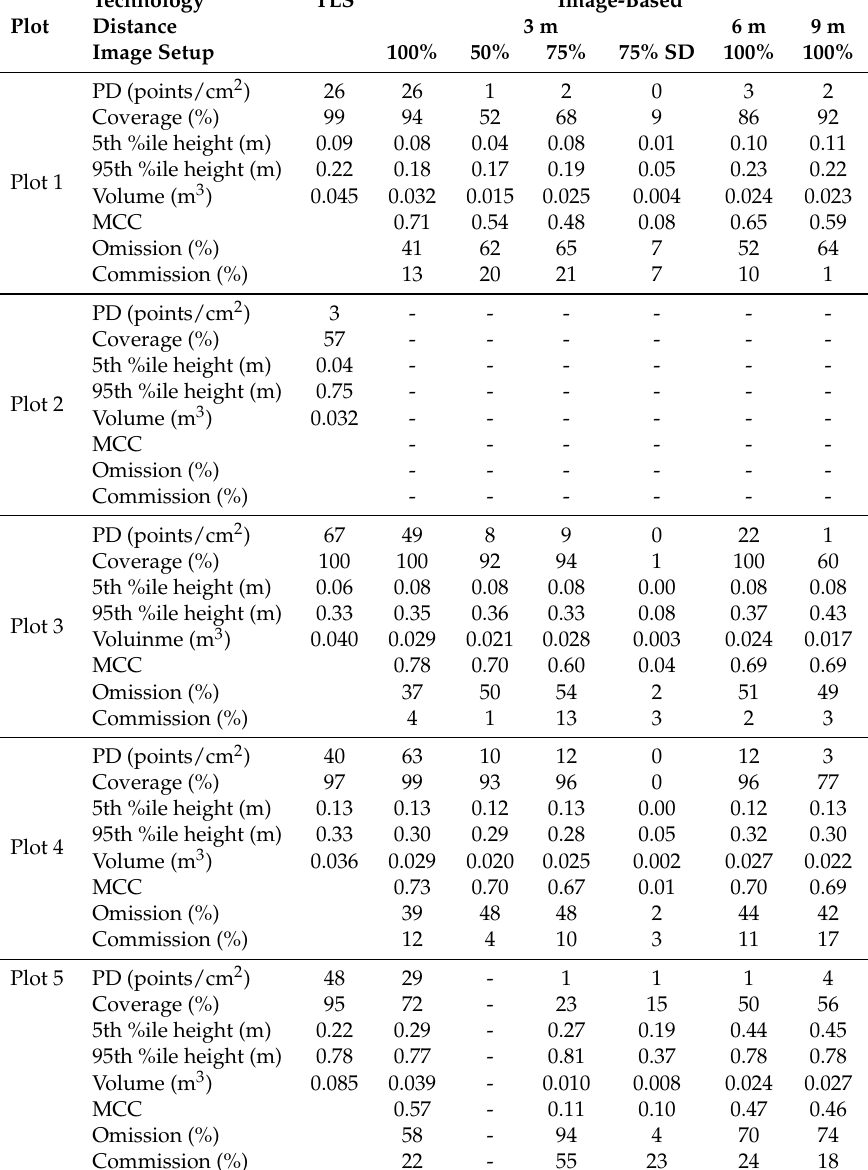
Table 1. Metrics describing the horizontal and vertical distribution of vegetation elements extracted from the terrestrial laser scanning (TLS) and image-based point clouds. Standard deviation is provided for the 3 m 75% representation based on point clouds derived from the 10 randomly selected photo